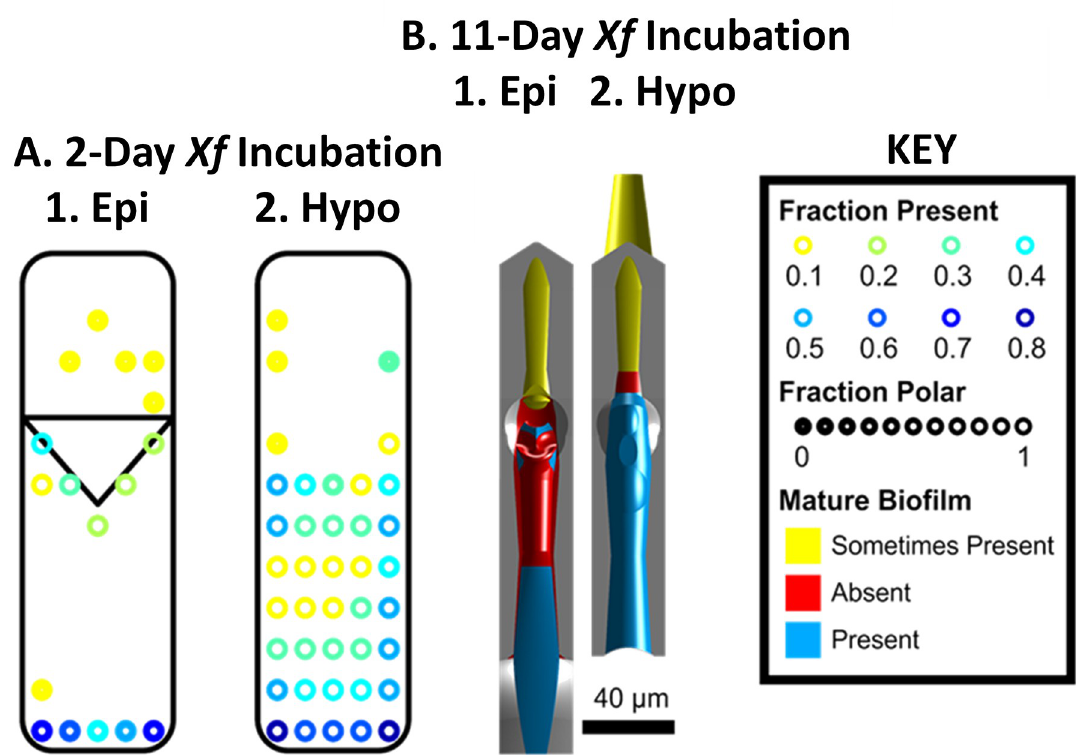
Fig 4. Colonization/biofilm patterns of X. fastidiosa (Xf) in the precibarium of G . atropunctata after A. a 2-day incubation period, and B. an approximately 11-day incubation period; 1. Epipharynx (Epi), 2. Hypopharnx (Hypo). A. Subfigures summarize the findings of Almeida and Purcell [6] by combining their 12 published diagrams of epipharynx and hypopharynx colonization. These images are not drawn to scale of the precibarium, and the triangle represents the precibarial valve flap. The color of the circles represents the fraction of published observations of a given location that indicated cells were attached (see KEY). The amount of circle fill represents the fraction of attached cells that were polarly attached. B. Subfigures summarize the location of developed biofilms in the precibarium, as gathered from several published descriptions and published microscope images [6, 12, 13, 32]. Blue represents colonized segments, red represents uncolonized segments, and yellow represents segments that are sometimes colonized.